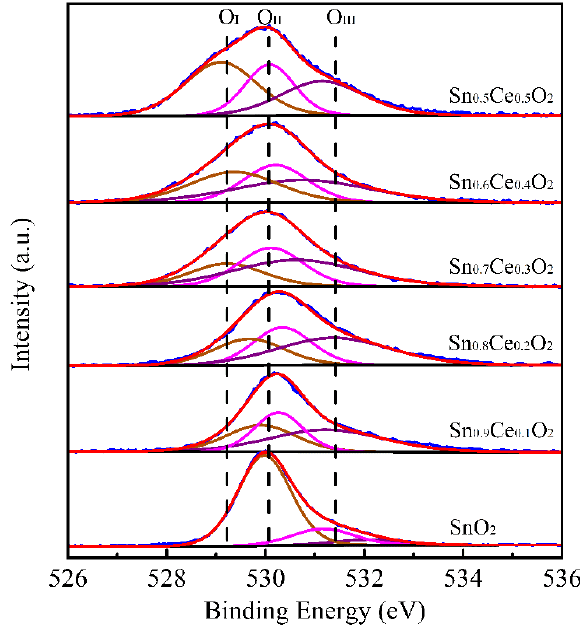
Figure 11. XPS spectra in the O 1s region of the SnO 2 and Sn x Ce 1-x O 2 fiber catalysts. Table 2. XPS parameters for Sn, Ce, and O of the SnO 2 and Sn x Ce 1-x O 2 fiber catalysts.